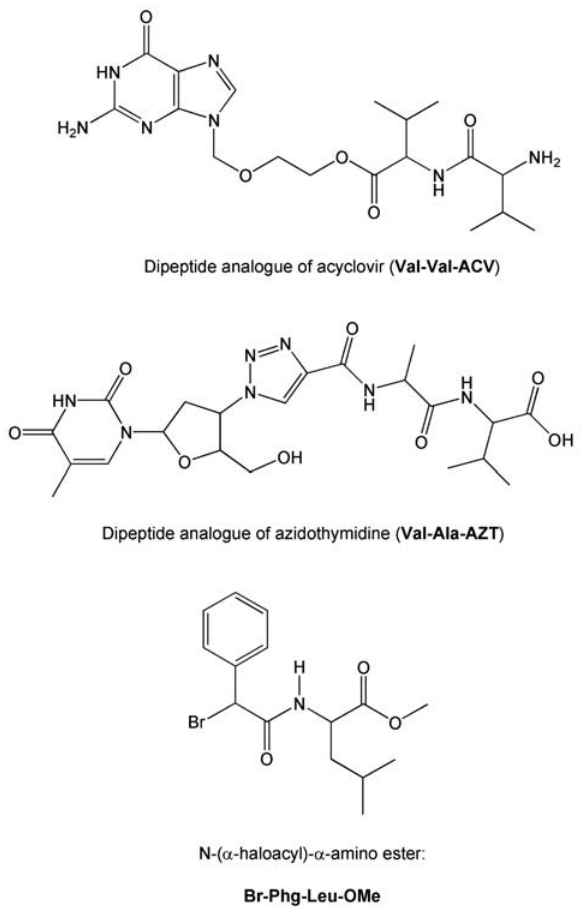
Figure 1. Dipeptide analogues of acyclovir and azidothymidine, cyclodidepsipeptides and N -( α -haloacyl)- α -amino